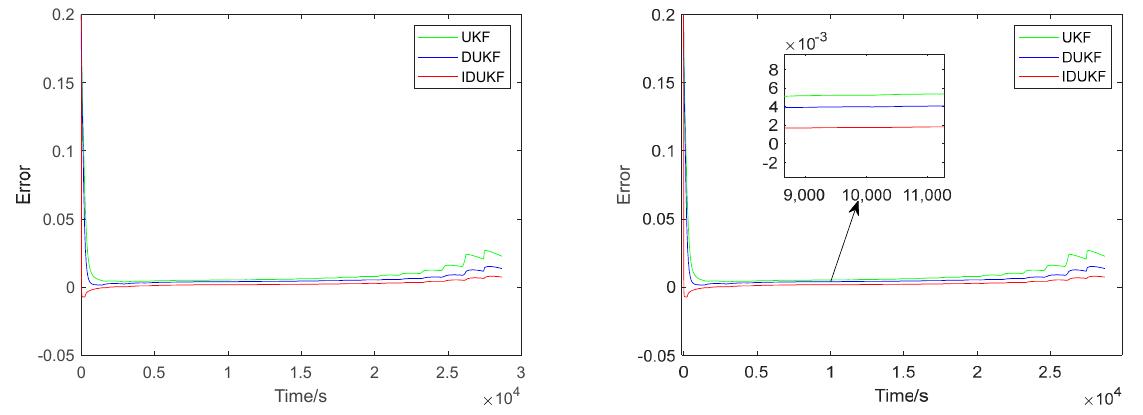
Figure 15. The error curves in the CCPC tests.